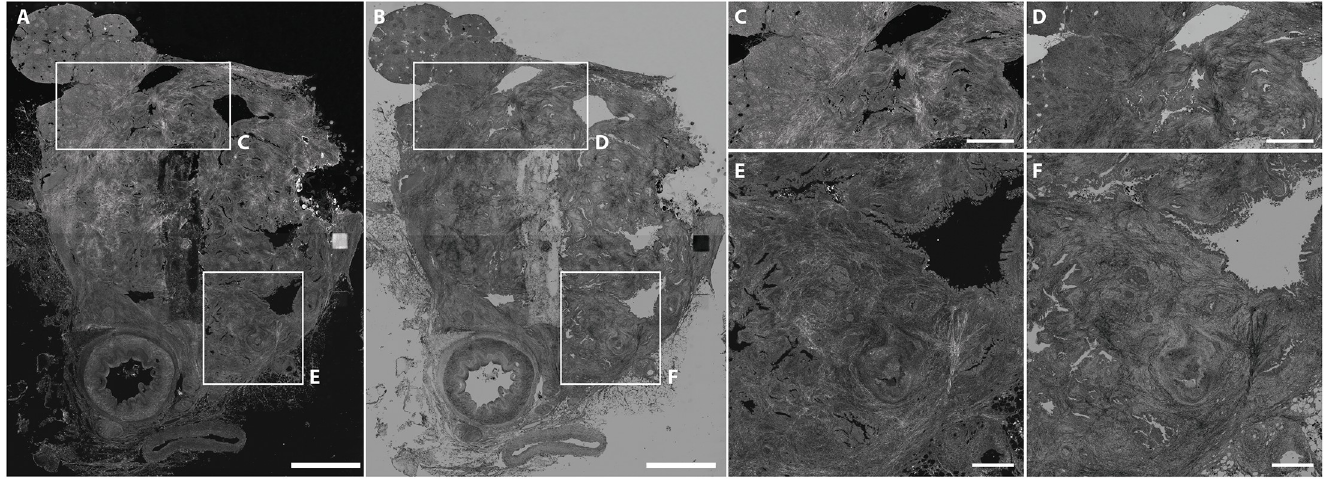
Fig 1. Example FF-OCT image of a well-differentiated pancreatic ductal adenocarcinoma as shown to the pathologist for assessment. The wholeFF-OCT images were shown to the pathologists, but they were asked to only assess the selectedregions of interest (two per FF-OCT image). Both the original(A,C,E) and the inverse(B,D,F) FF-OCT images are shown. Scale bars, 5 mm (A,B), 2 mm (C,D), and 1 mm (E,F).